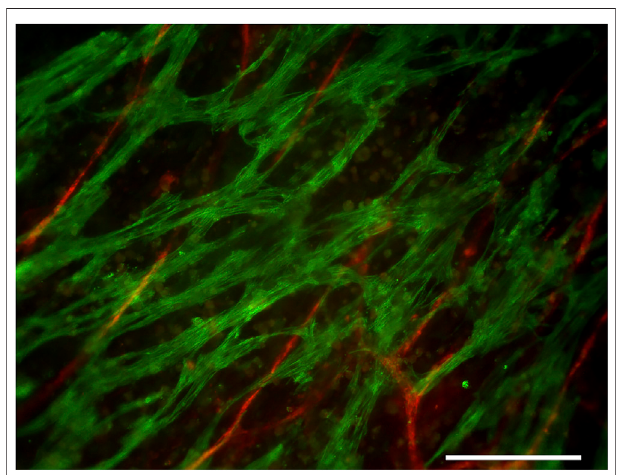
FIGURE4| Cardiac troponin T(green) – positivecardiomyocytes and the von Willebrand factor (red) – positive vascular network. Scale bar: 200 µm.